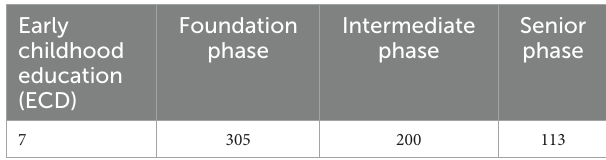
TABLE 3 Number of students studying in the different phases.